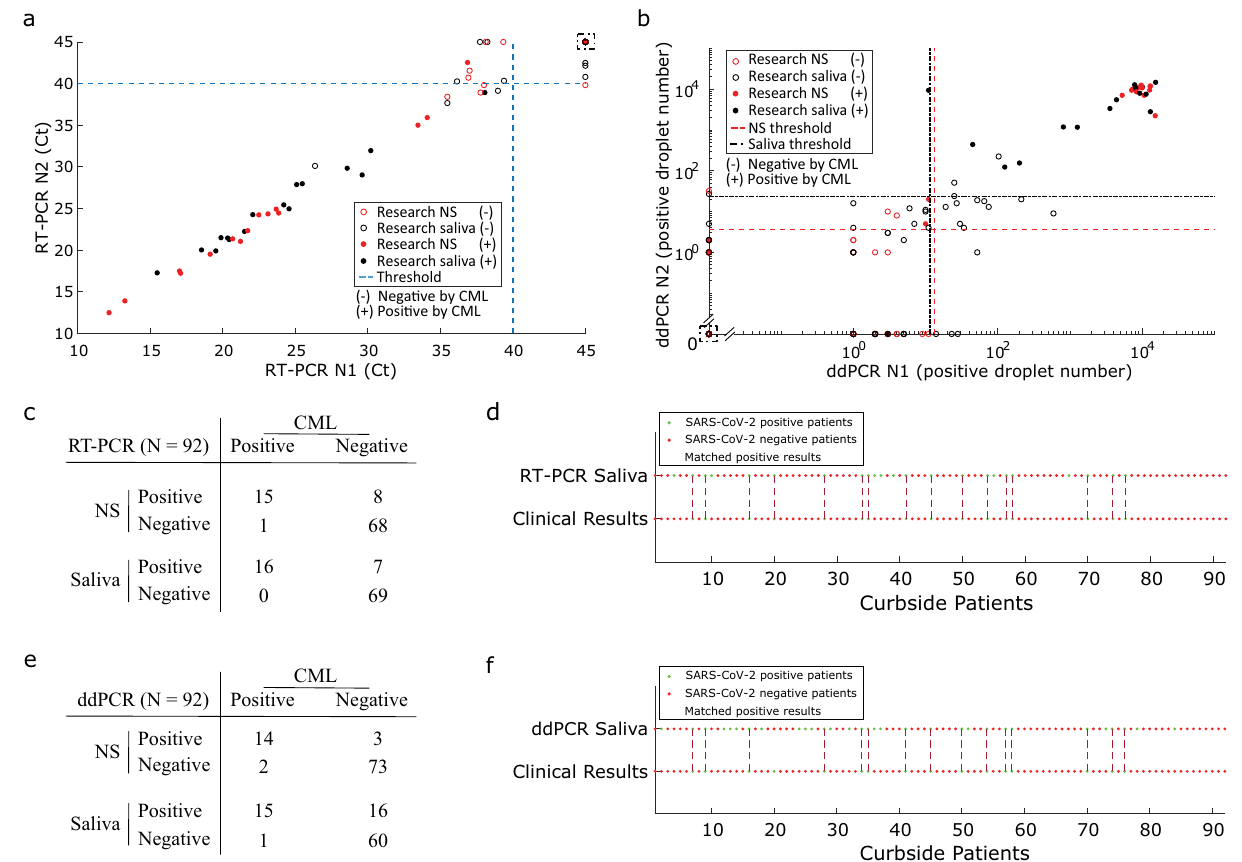
Figure 2. Saliva-based SARS-CoV-2 testing shows excellent concordance and sensitivity with nasal swab assay across curbside collected patient specimens. Curbside collected NS samples were analyzed at the certified microbiology laboratory (CML) using a RT-PCR based EUA approved assay, while matched saliva samples and additional NS specimen collected from each individual were analyzed by our research laboratory using optimized RT-PCR and ddPCR assays. ( a ) N1 vs. N2 gene concordance for NS and saliva samples measured by the RT-PCR assay at our research laboratory. Filled dots represent cases tested positive by the EUA approved diagnostic assay. Dashed blue lines at Ct value of 40 for N1 and N2 indicate CDC-recommended thresholds for RT-PCR assays using these primers/probes. Dashed box contains data from multiple samples with Ct = 45 for N1 and N2 (a total of 67 NS and 66 saliva samples). ( b ) N1 vs. N2 gene concordance for NS and saliva samples measured by the ddPCR assay at our research laboratory. The filled dots represent cases tested positive by the EUA approved diagnostic assay. The dashed lines indicate ddPCR thresholds determined by analyzing a cohort of 45 asymptomatic individuals who were SARS-CoV-2 negative by the CML test (Supplementary Table 2). Dashed box includes samples with 0 positive ddPCR droplets for N1 and N2 (a total of 38 NS and 17 saliva samples). ( c ) Comparison of cases detected by our NS and saliva RT-PCR assays to the CML NS results. Each number in the table represents cases detected as positive or negative by both our RT-PCR assay and by the CML. For example, in NS samples our RT-PCR assay detected 15 positive patients that are also detected as positive by the CML. On the other hand, our NS RT-PCR assay detected additional 8 positive patients that are detected as negative by the CML. Our saliva RT-PCR assay detected all (16 out of 16) positive cases that were detected as positives by the CML NS test. ( d ) Comparison between matched research RT-PCR saliva results and diagnostic facility NS results. The green and red dots indicate positive and negative cases respectively. The maroon dashed lines connecting the dots indicate patients tested positive by both assays. ( e ) Summary of the positive cases detected in NS and saliva samples by ddPCR assay (as in c ). ( f ) Comparison between matched ddPCR saliva results and diagnostic facility NS results. The green and red dots indicate positive and negative cases respectively. The maroon vertical dashed lines connecting the dots indicate patients tested positive by both